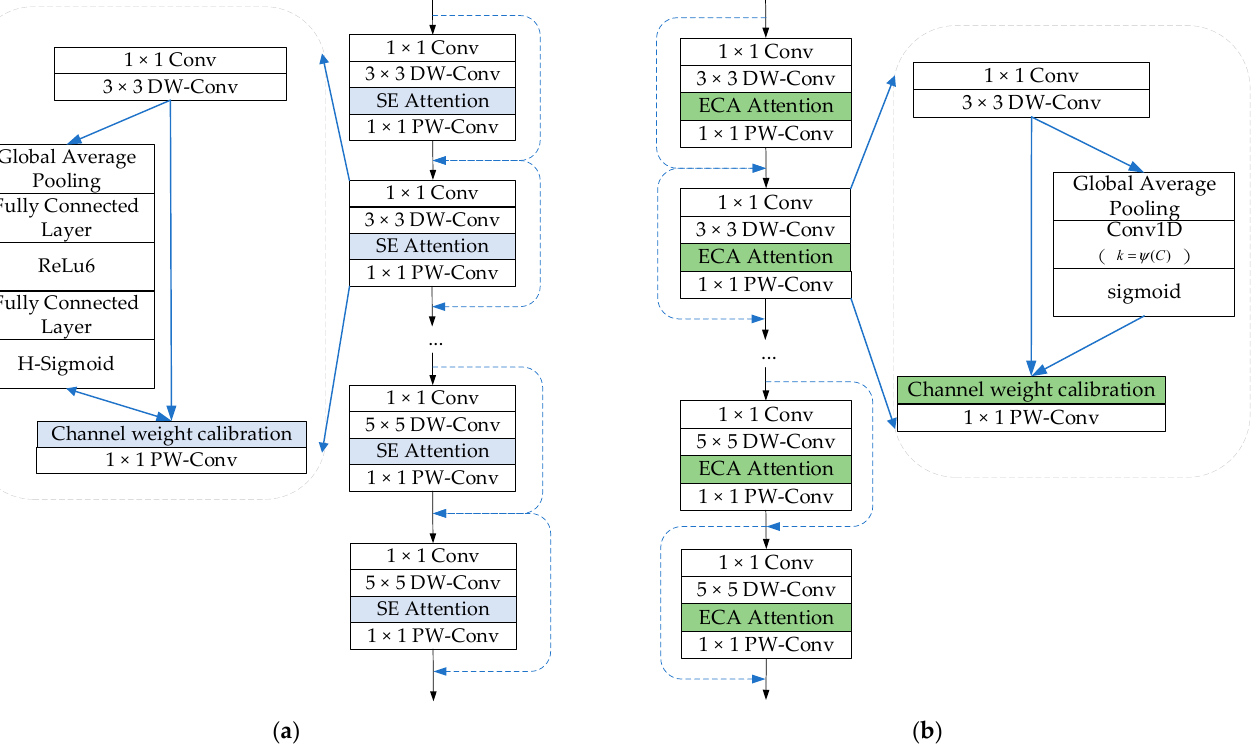
Figure 1. Comparison of the backbone network structure of the two algorithms before and after the improvement. ( a ) Backbone network structure of the MobileNetV3. ( b ) Backbone network structure of the ECA-MobileNetV3.